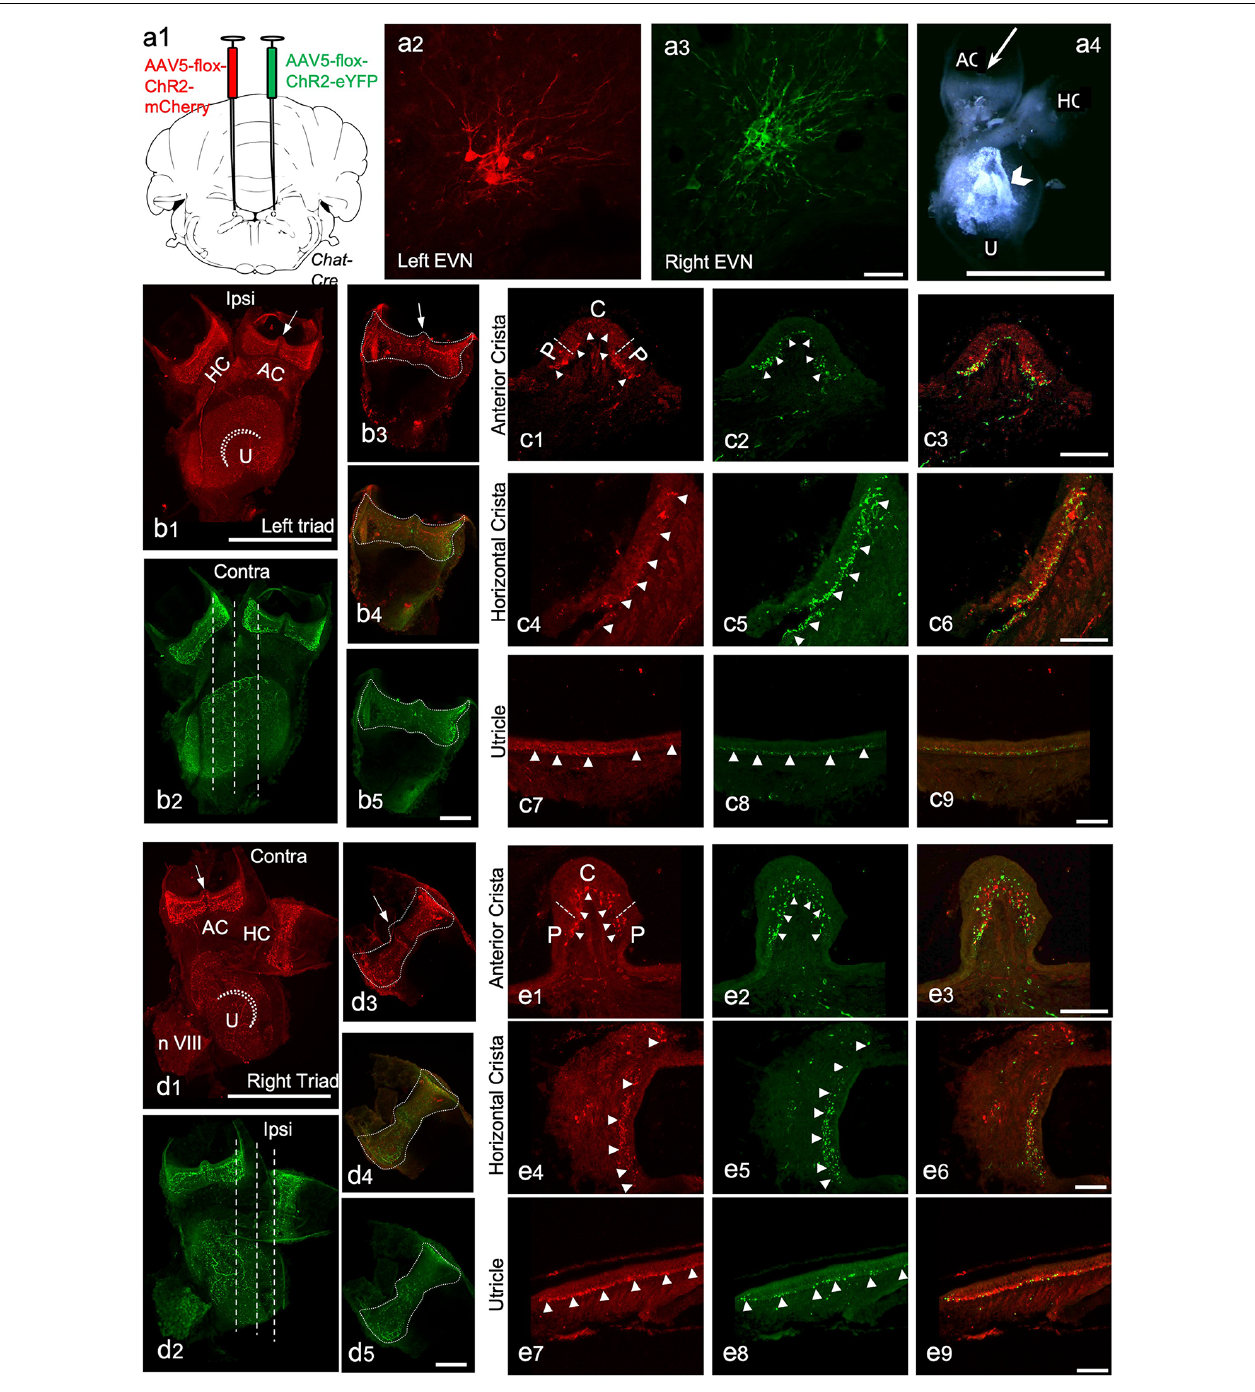
FIGURE 5 | The peripheral components of the Efferent Vestibular System. We used adeno-associated viruses (AAVs) to induce the expression of red and green fluorescent marker proteins in EVN neuronal cell bodies, their axons, and terminal fields in peripheral vestibular organs. Here we show the peripheral vestibular organs. (A) a1 —the injection sites of AAV5-Chr2-mCherry (left) and AAV5-Chr2-EYFP (right) anterograde viruses in the brainstem; a2,a3 —viral labeling of left EVN by mCherry red fluorescent protein and right EVN by EYFP fluorescent protein, Scale bar: 50 µ m; a4 —dissected vestibular organs, a semi-intact triad of anterior crista (AC), horizontal crista (HC) and utricle (U), arrowhead points at the otolith crystals, Scale bar: 1 mm. (B) b1,b2 —maximum projection of z-stack from the left side triad visualized using red (mCherry) and green (EYFP) channels ∼ 3 weeks after virus injection in the brainstem. Arrow—eminentia cruciata; straight dashed line-showing the planes of sectioning; dashed curved line-striola in the utricle, HC—horizontal crista, AC—anterior crista, Scale bar: 500 µ m; b3–b5 —maximum projections of the